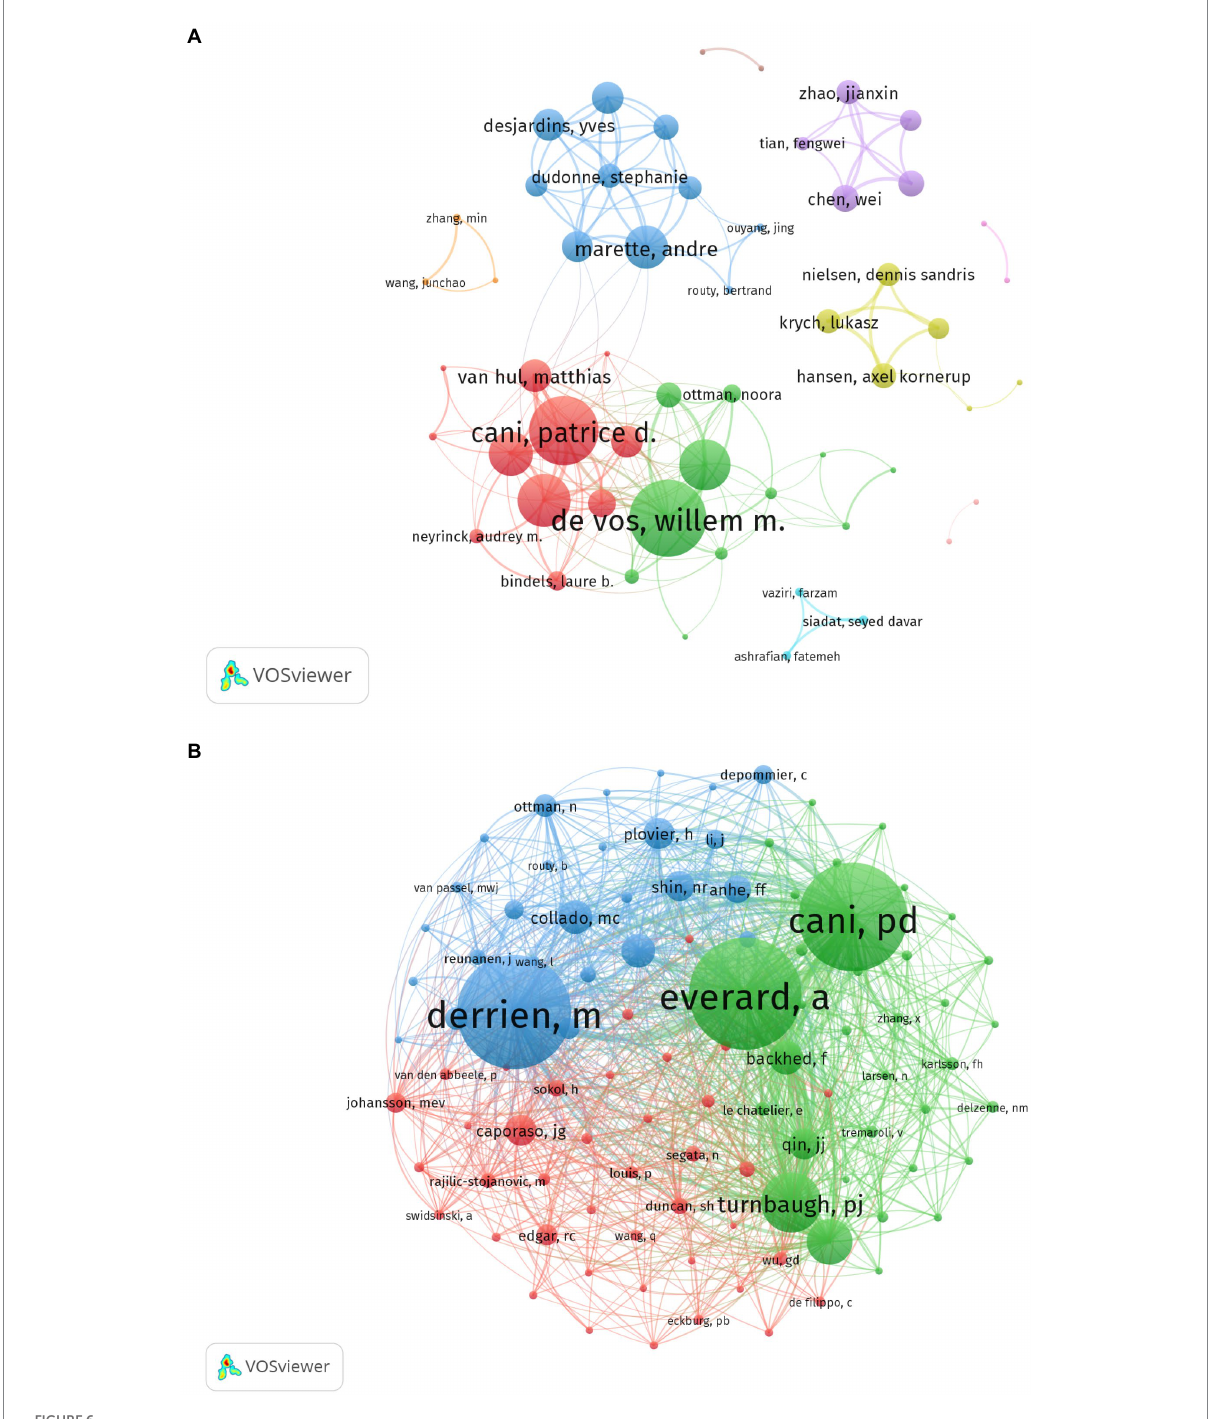
FIGURE 6 Contribution analysis of authorship in A. muciniphila research. (A) Co-authorship analysis of authors. Each node represents a different author. After the network was generated, cooperation between authors was shown as same-colored clusters. The size of the nodes reflects the strength of their cooperation. (B) Co-citation analysis of cited authors generated by VOS viewer. Each node represents a different cited author. The size of the nodes is weighted by